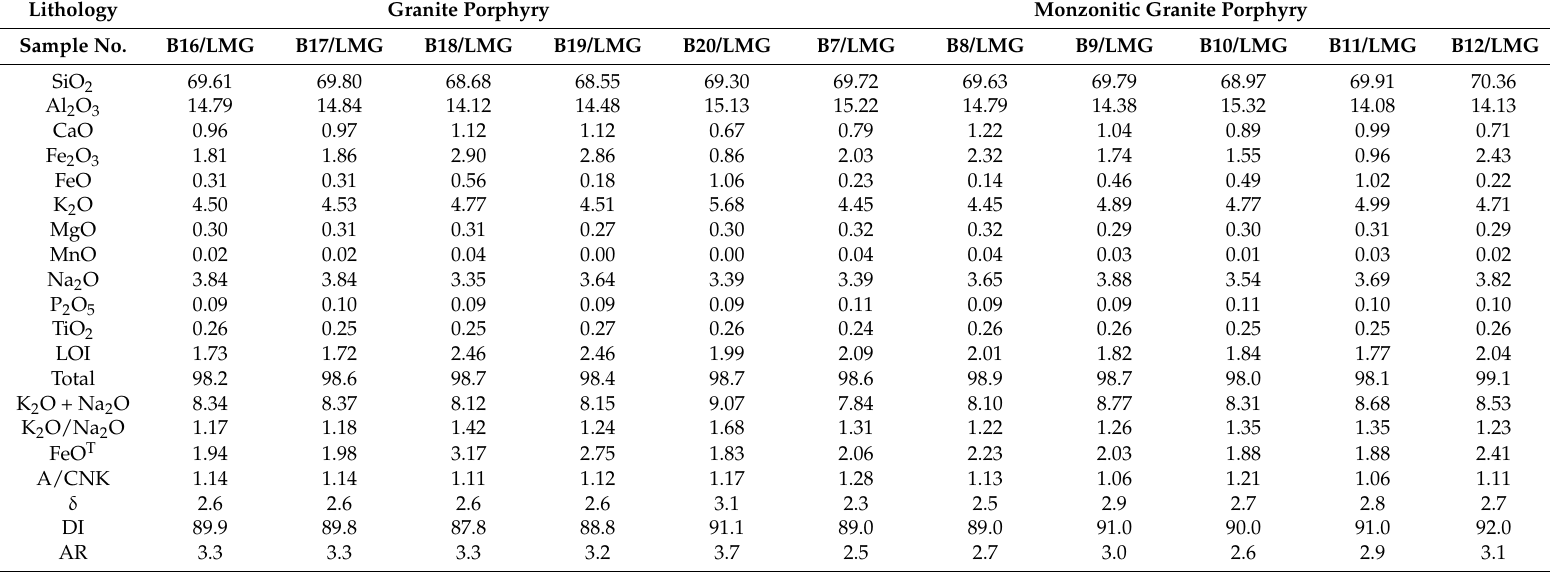
Table 2. Major elements (%) of the Leimengou granite porphyry and monzonitic granite porphyry. Lithology Granite Porphyry Monzonitic Granite Porphyry Sample